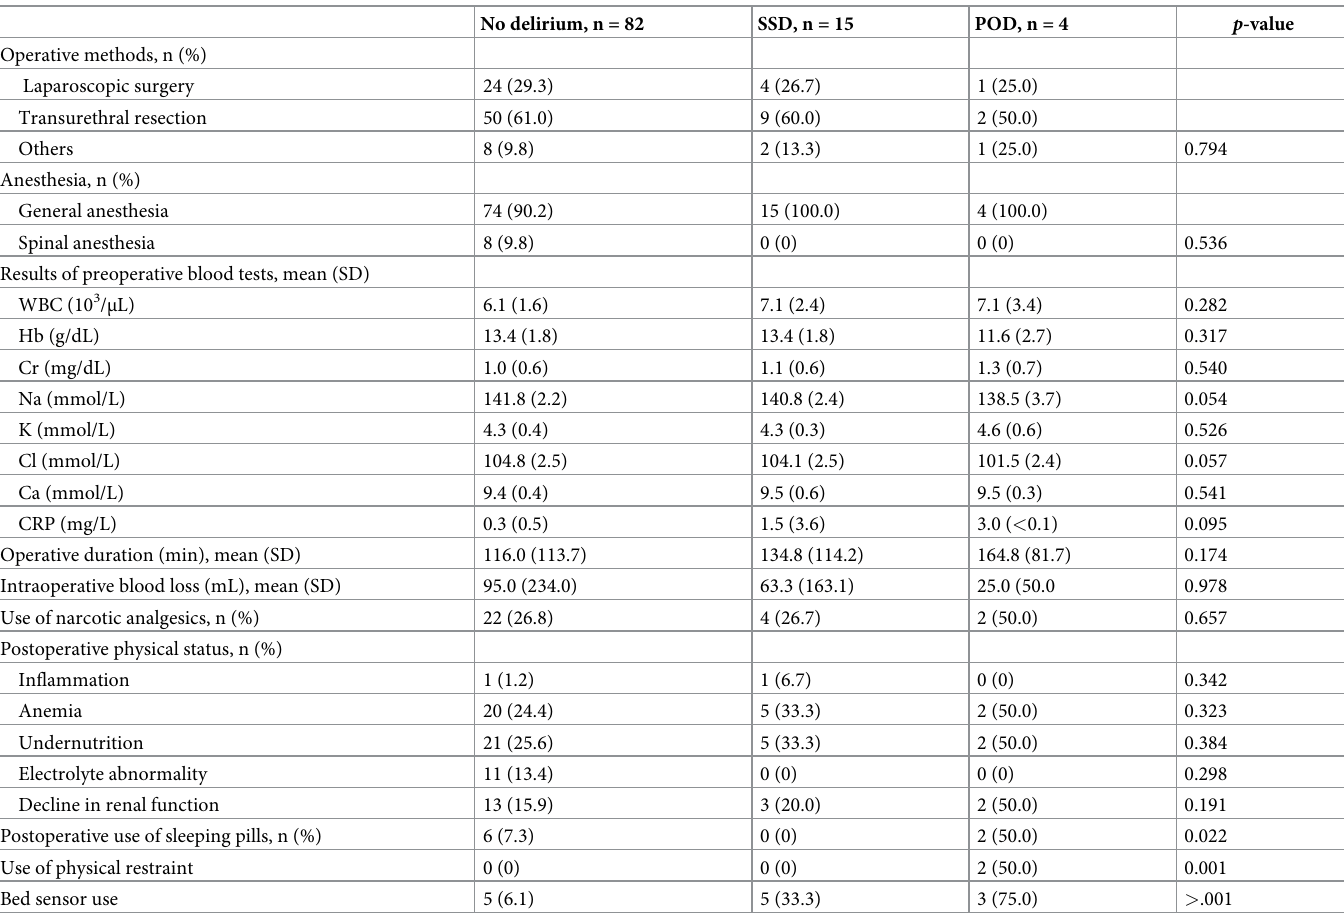
Table 6. Differences in surgical clinical variables (no delirium vs. SSD vs. POD).